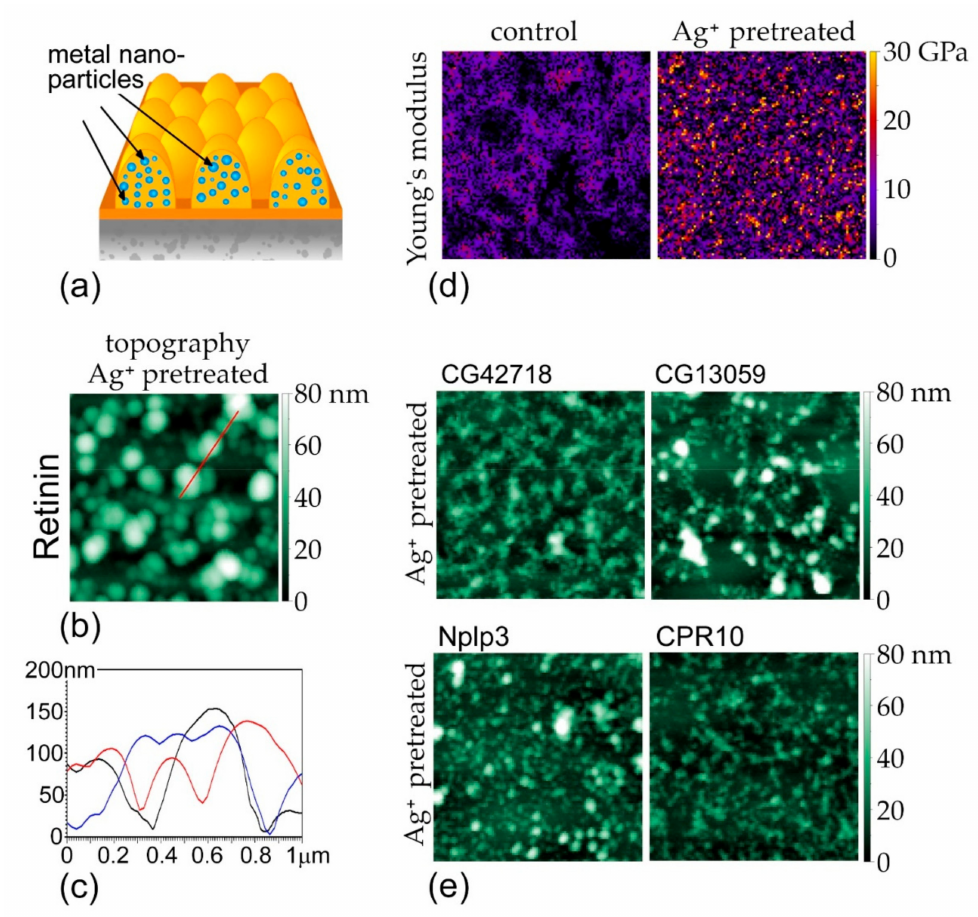
Figure 4. Armament with metal nanoparticles growing before the process of self-assembly ( a ) results in a pronounced topology of Retinin-based nanocoatings, incorporating silver nanoparticles ( b ). Red line is a cross section used to plot the heights. ( c ) Cross sections through Ag + -pretreated nanocoatings showing representative heights of the nanostructures (three different cross sections are shown in different colors, red is from the image in ( b ), black and blue from other images). ( d ) Young’s modulus of Ag + -pretreated nanocoatings is intermediate, between that of protein-based and metal-based surfaces. ( e ) Topology of silver-incorporating nanocoatings, based on Retinin-like proteins CG42728, CG13059, Nplp3, and CPR10. Scans in ( b , d , e ) are 2 × 2 µ m; surface height and Young’s modulus are indicated by color scales, next to the